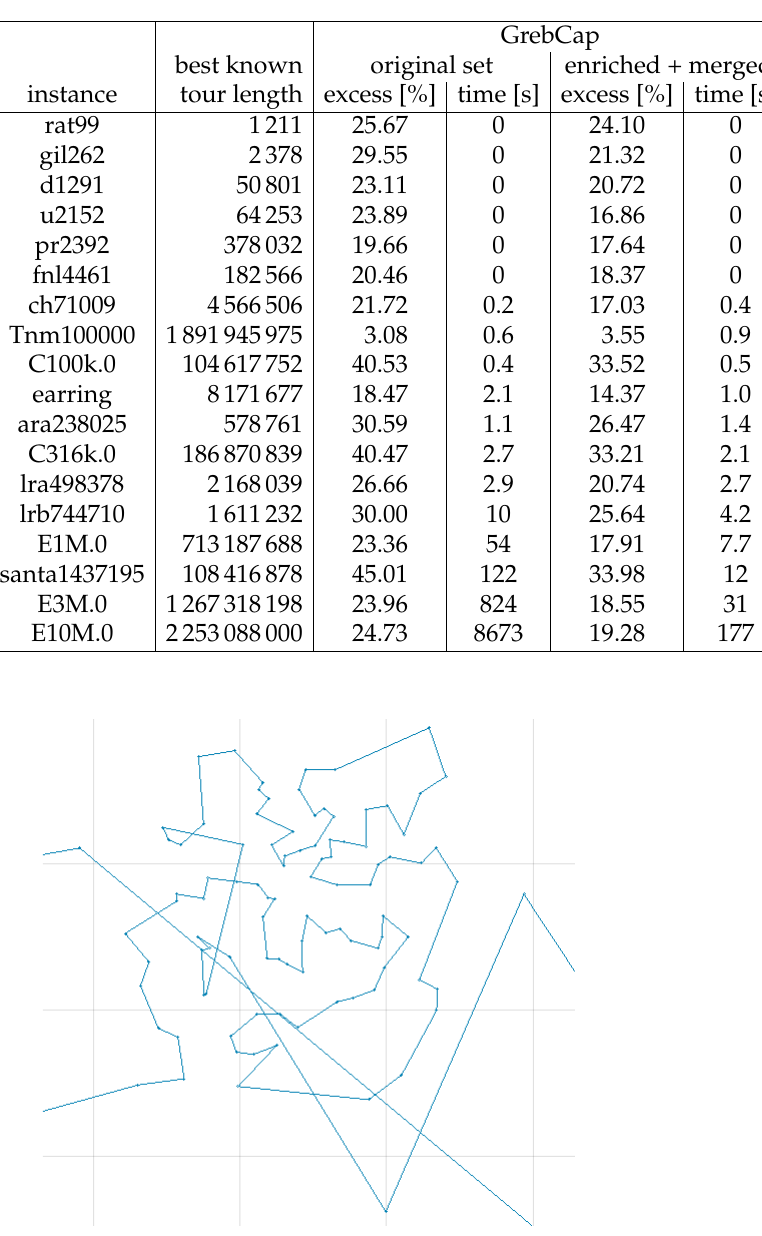
Table 2. Quality of initial tours dependent on chosen method (excess over best known tour) and duration for building the tour. The number of points per instance is given in the file names.